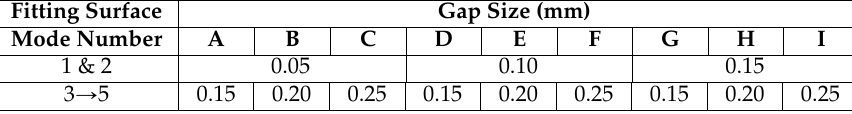
Table 8. Best gap sizes for the chosen possible passageway.